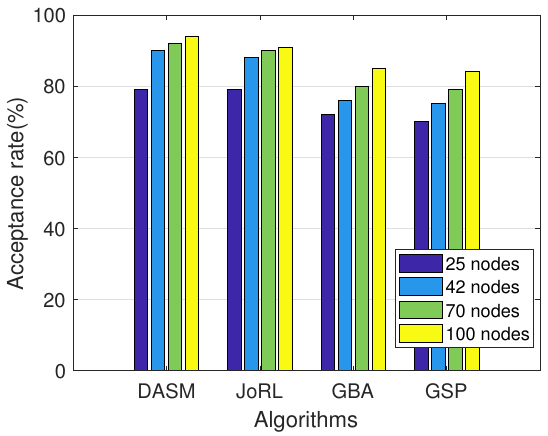
Figure 11. Service acceptance rate.